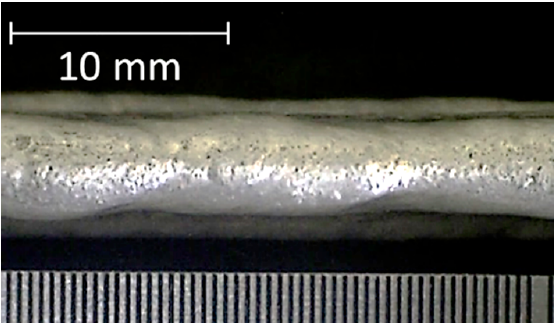
Figure 7. Surface aspect of run 12 (WFS of 8 m/min.), which did not meet the acceptance criteria. In terms of relative density (taken as porosity measure), all preforms reached an acceptable level, as shown in Figure 8. This outcome corroborates previous results [12,15].